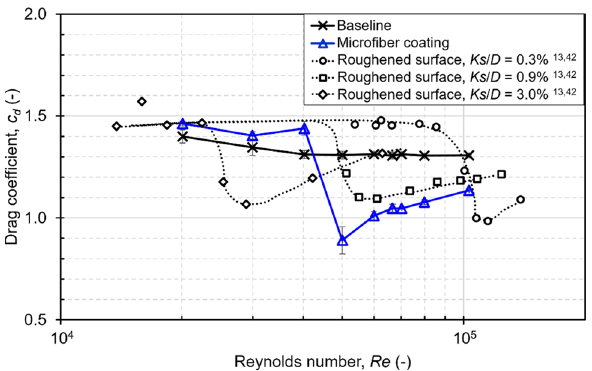
Figure 5. Drag coefficient c d of the fully microfiber-coated cylinder compared to a baseline cylinder and a cylinder with a roughened surface for a range of Reynolds Numbers Re